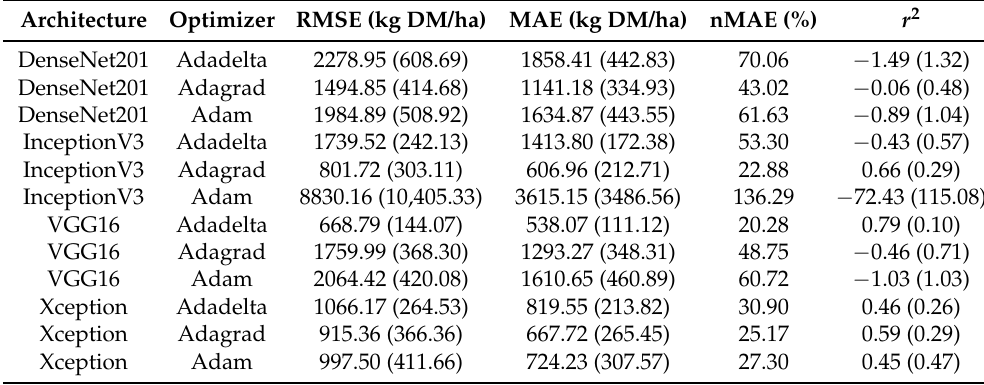
Figure 4. XY graphics for predicted versus measured dry matter yield (DMY) (kg DM/ha) points arising from the best run for each architecture. The regression lines are shown in blue and the grey area is the confidence interval. Table 4. Dry matter yield root mean squared error (RMSE) (kg DM/ha), mean absolute error (MAE) (kg DM/ha), normalized mean absolute error (nMAE) (%) and coefficient of determination ( r 2 ) means and standard values over the 8-fold test set for all the architectures and